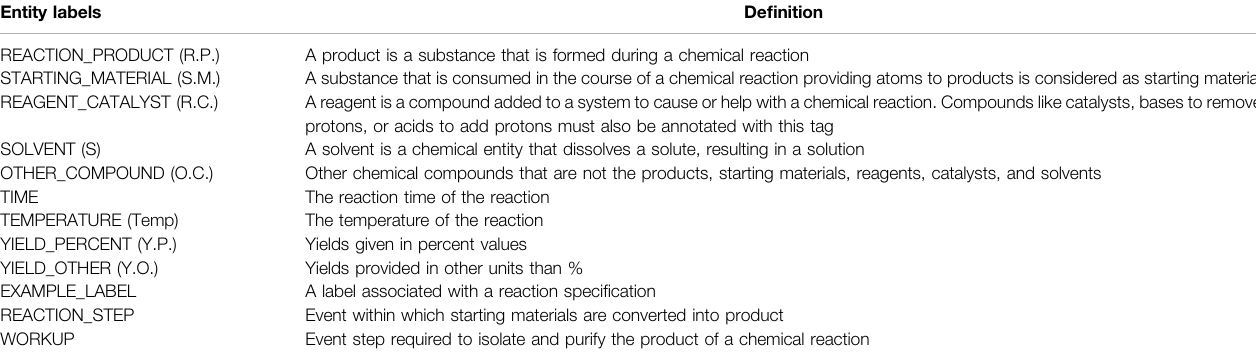
TABLE 1 | De fi nitions of entities and trigger words of the dataset. Entity labels De fi nition REACTION_PRODUCT (R.P.)